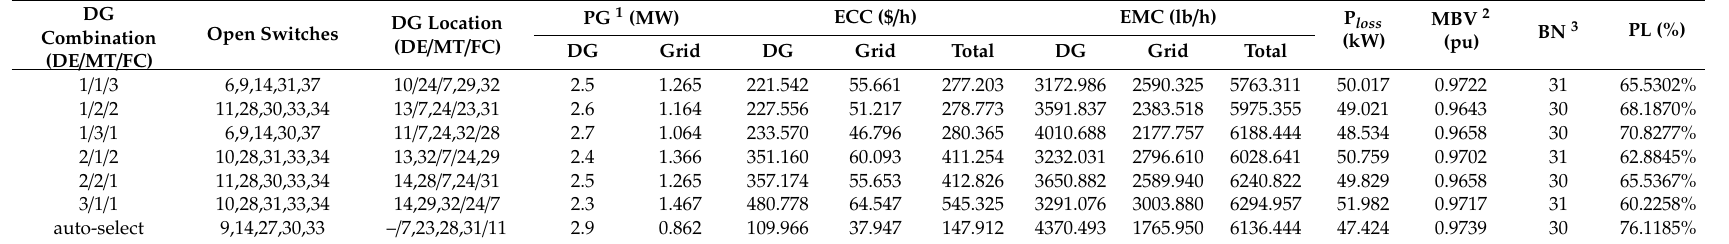
Table 9. Reconfiguration results under various combinations of 5 DGs.